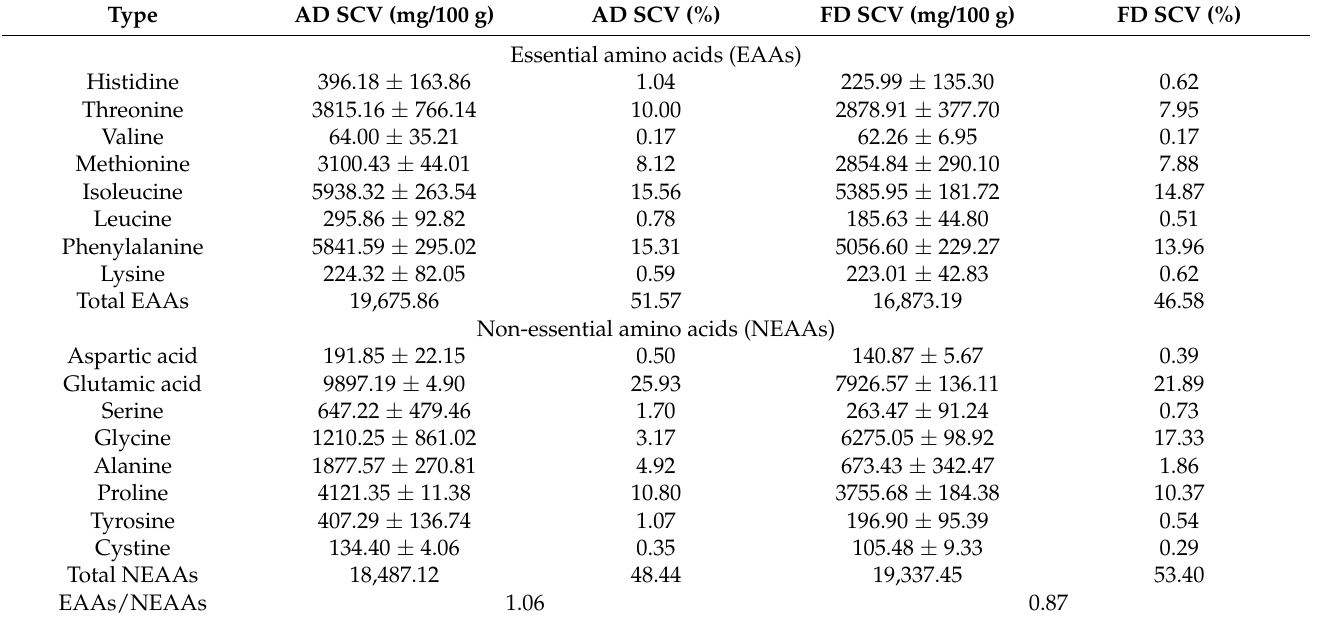
Table 6. Amino acid composition of air-dried (AD SCV) and freeze-dried (FD SCV) sea cucumber viscera.